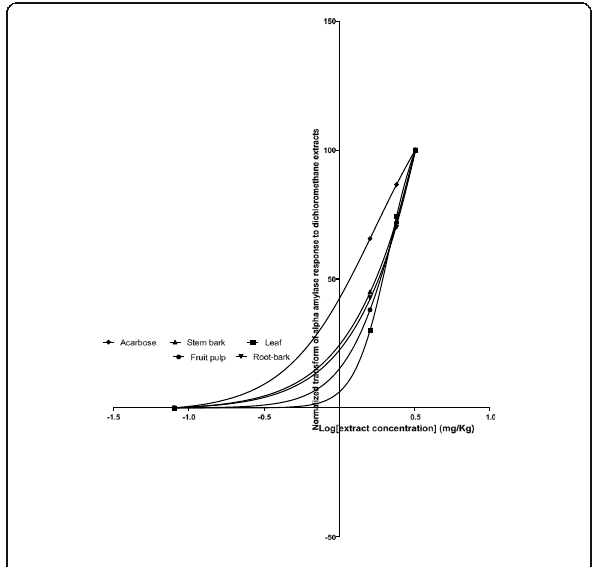
Fig. 7 Dose-response curve of α -amylase inhibition by